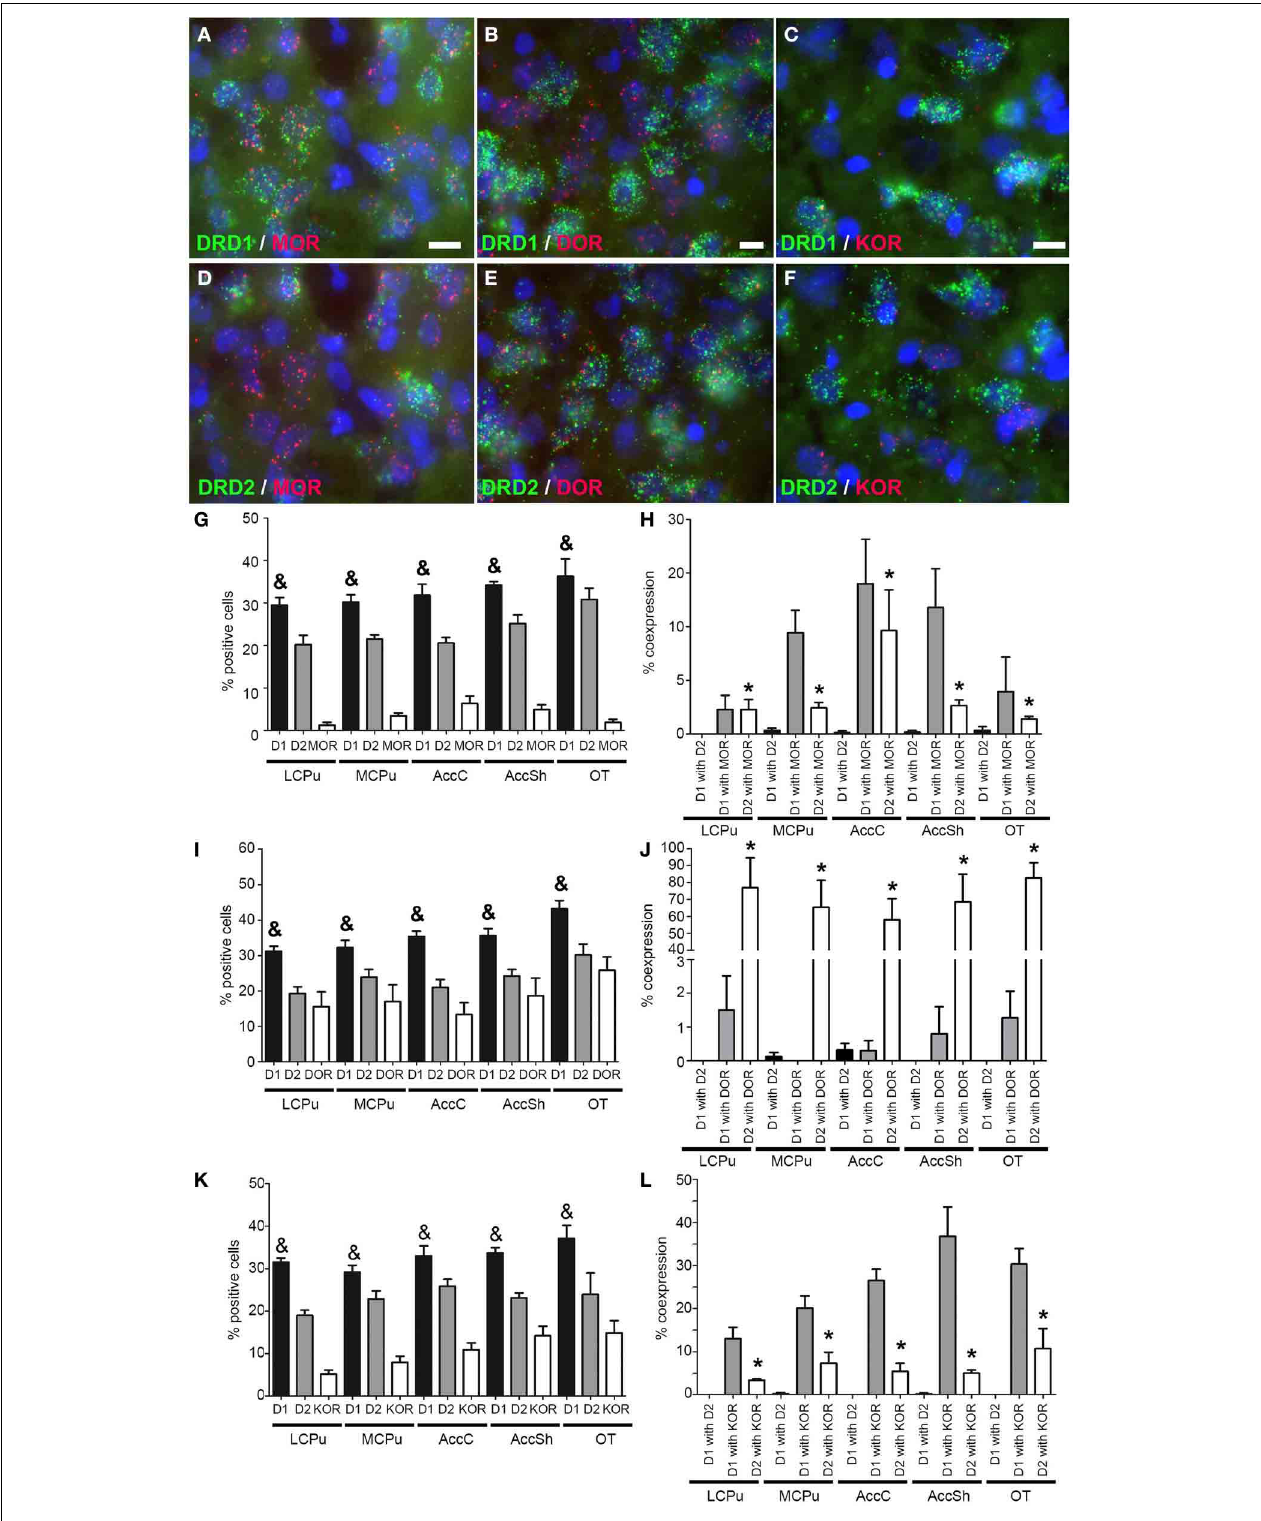
FIGURE 4 | Coexpression of the opiate receptors with both DRD1 and DRD2 . (A–F) Example of staining in the striatum. Nuclei were stained using DAPI (blue). Coexpression depicted in red and green for the described receptors. White bar, 25 μ m. (A,D) Coexpression for DRD1 and mu-opioid receptor ( MOR ), also for DRD2 and MOR . (B,E) Coexpression for DRD2 and